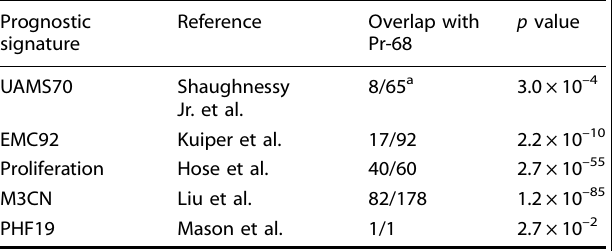
Table 2. Existing prognostic signatures of high-risk MM map to